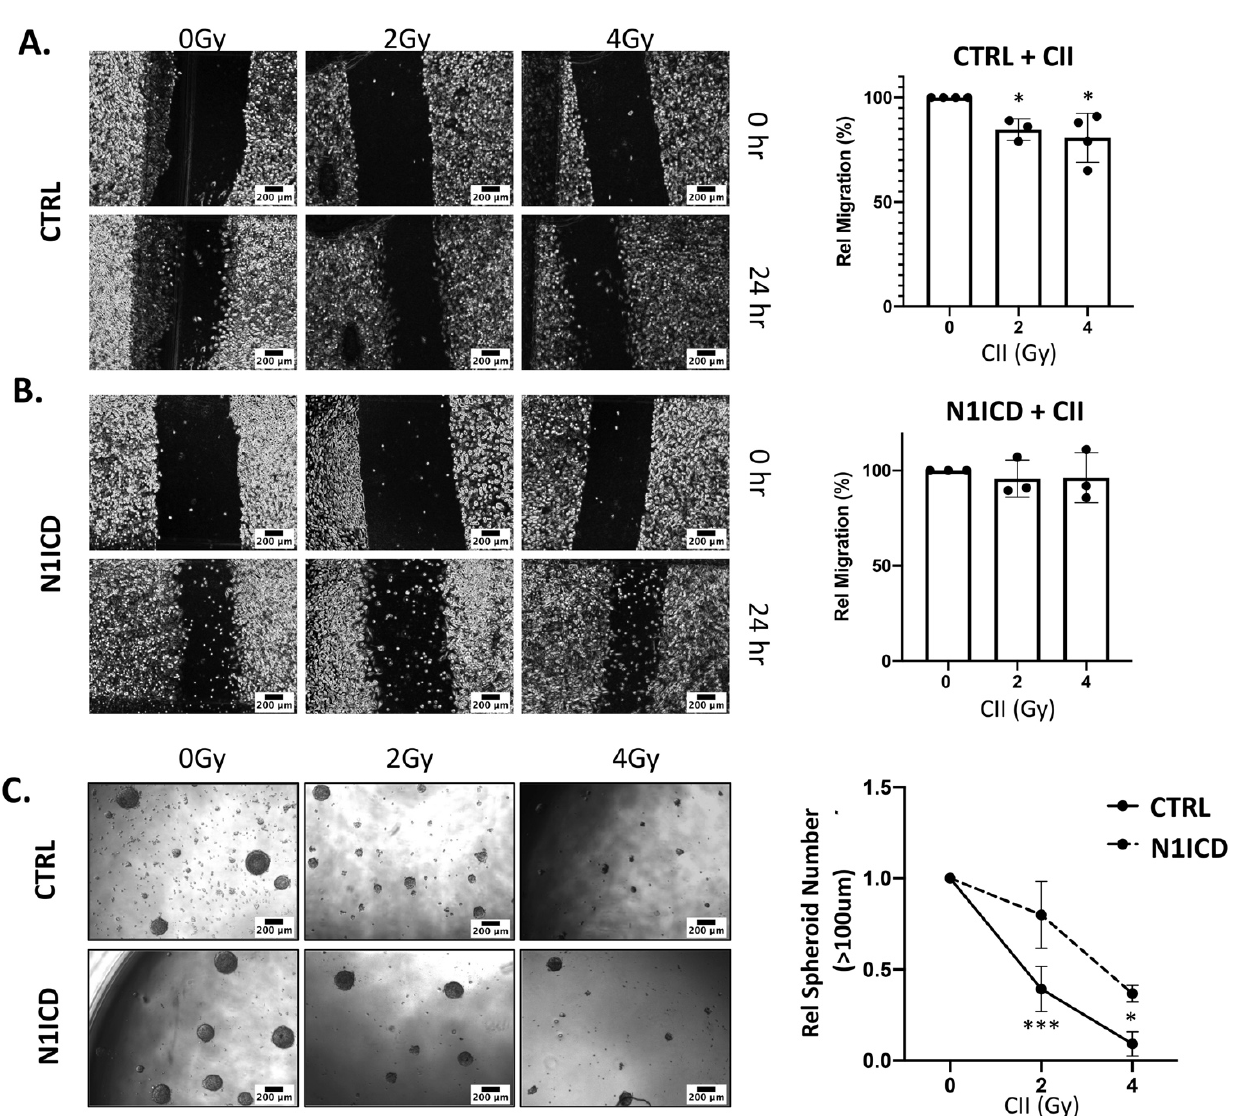
Figure 6. Overexpression of N1ICD attenuates the effect of CII on LN229 migration and spheroid formation: Representative images of the cell migration after CII irradiation on (( A ), left) Control or (( B ), left) N1ICD overexpressing LN229 cells, as analyzed by scratch assay (scale bar in black = 200 μm); (( A ), right) Relative migration derived from panel ( A ); (( B ), right) Relative migration derived from panel ( B ). Each symbol in the bar graph represents an independent experiment. Data are presented as mean ± SD. p values were determined by an unpaired two-tailed Student’s t -test, * p < 0.05, ** p < 0.01; (( C ), left) Representative microscopic image of the spheroid was formed at day 14 (scale bar in black = 200 μm); (( C ), right) Relative spheroid number derived from ( C ). Each experiment was performed in triplicate. Data are from 3–4 independent experiments and presented as mean ± SD. Statistical analysis was performed by ANOVA with Bonferroni post-hoc test. p -values (* p < 0.05, *** p < 0.001).